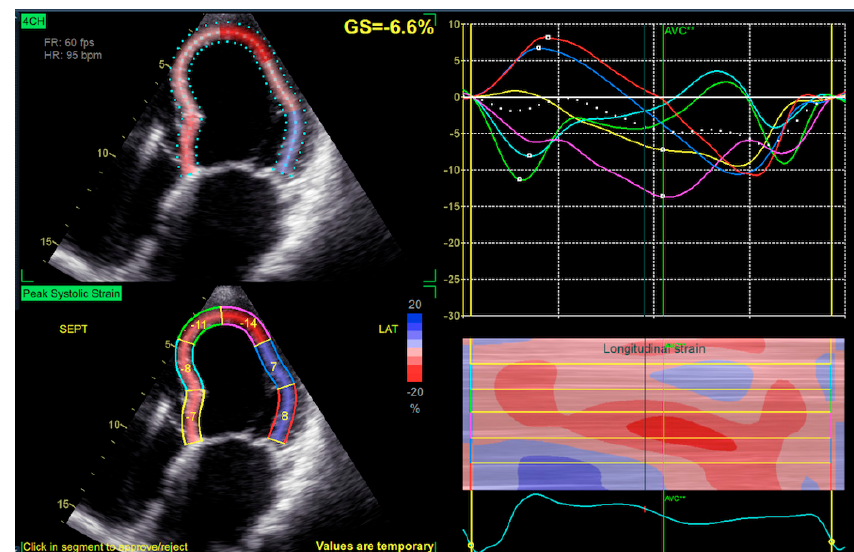
Figure 1. Four–chamber view of automatic function imaging (AFI), peak systolic strain is visualized in the left lower part, global strain in the left upper part and corresponding waveforms in the right upper part, right lower part visualize surface extrapolated color mapped strain.